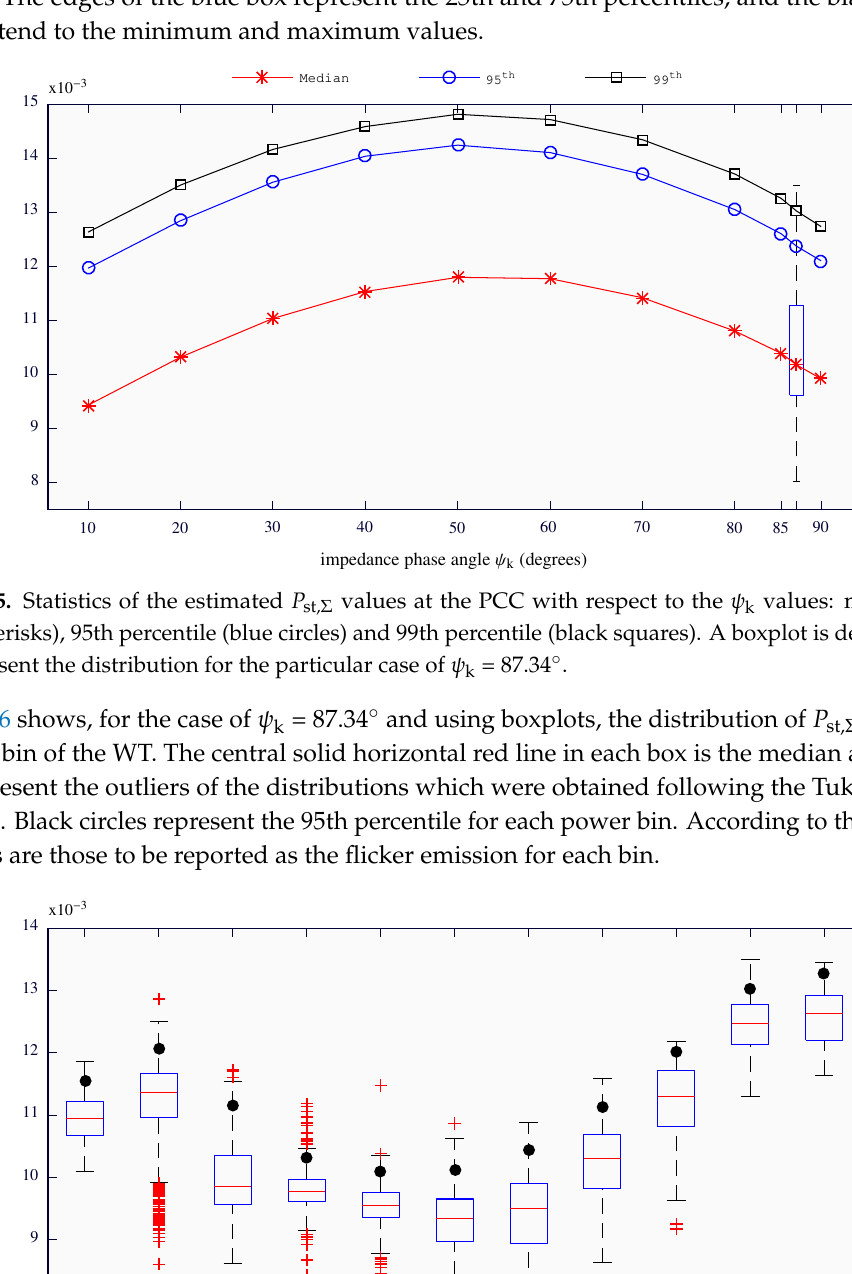
in Figure 5. The edges of the blue box represent the 25th and 75th percentiles, and the black dashed whiskers extend to the minimum and maximum values.